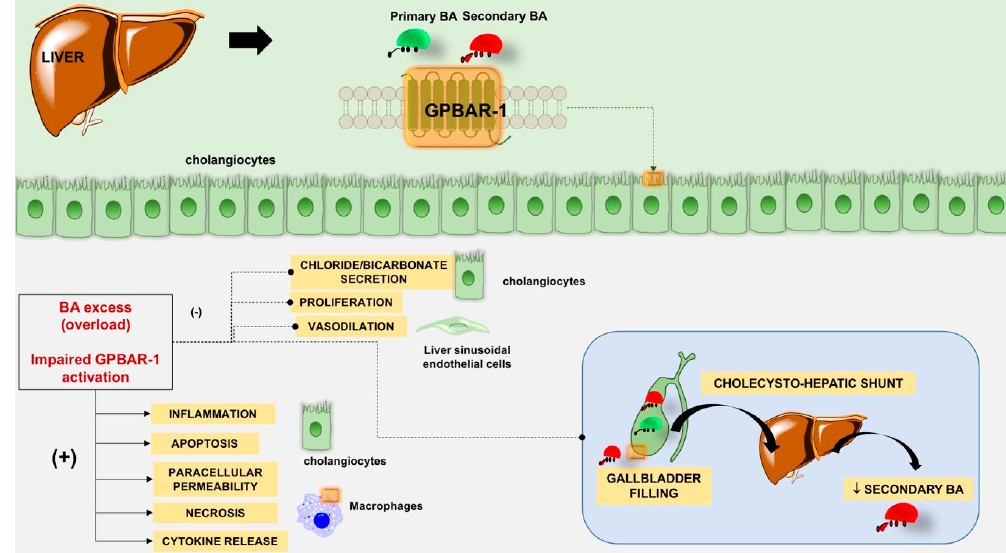
Figure 7. Main mechanisms of hepatoprotection involving GPBAR-1. The signs ( − ) or (+) indicate inhibition or activation, respectively.